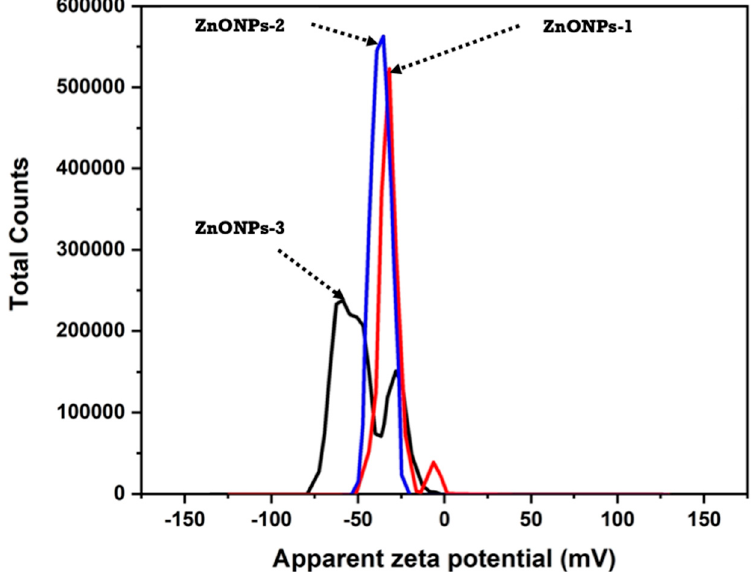
Figure 5. Zeta potential value of ZnONPs-1, ZnONPs-2 and